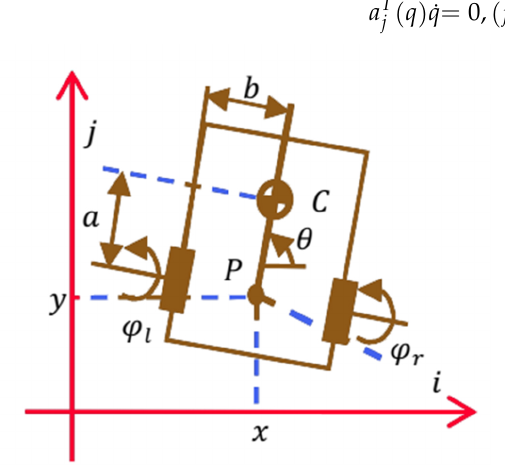
Figure 1. Parameter